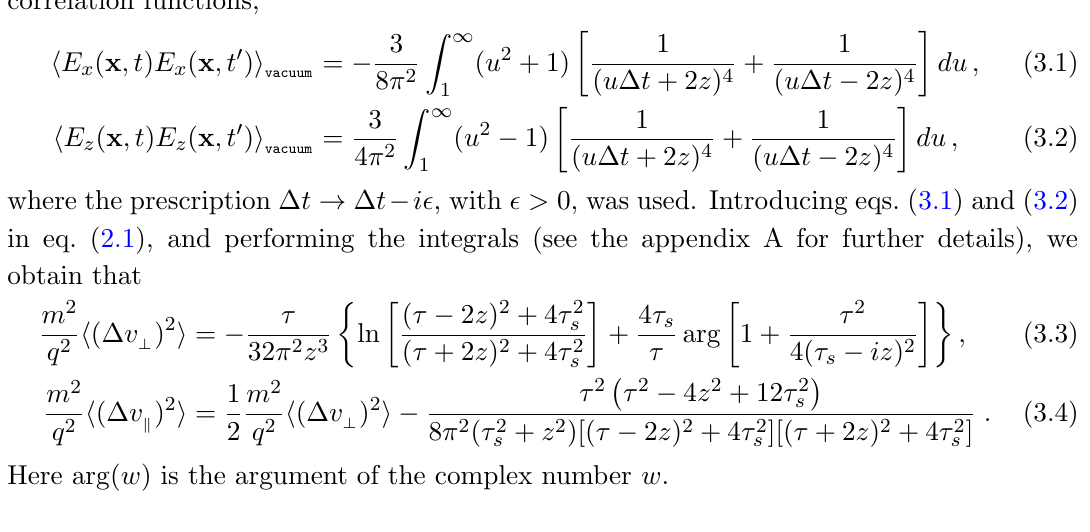
Figure 1 . Time behaviour of the switching function F time such that (cid:28) s =(cid:28) = 0 :